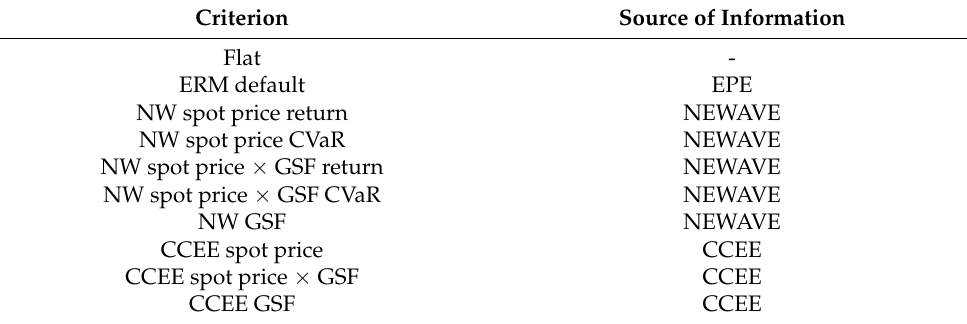
Table 1. Criteria in